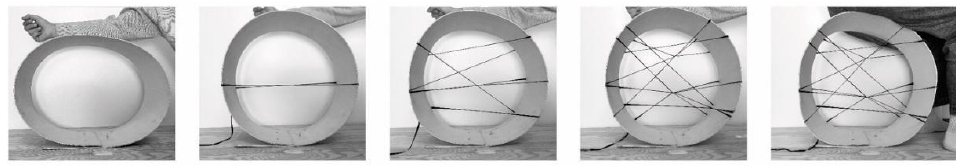
Figure 5. Initial study sequentially placing carbon FRP on a thin timber element, reinforcing most deformed regions.